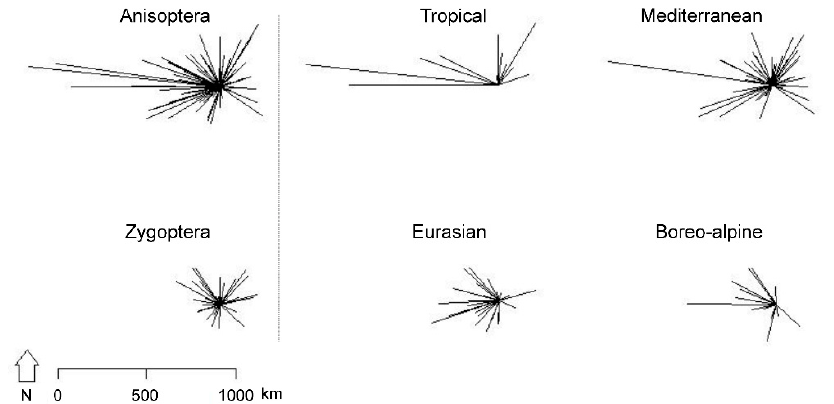
Figure 2. Plots showing shifts (1988–2010) in the range centroids of European (Odonata) dragonflies. Distance (km) and compass direction ( ◦ ) of range shifts in range centroids in species from 1988 to 2010. Data separated by taxonomic suborder (damselflies [Zygoptera] and true dragonflies [Anisoptera]) and biogeographical groups (Tropical, Mediterranean, Eurasian, and Boreo-alpine).